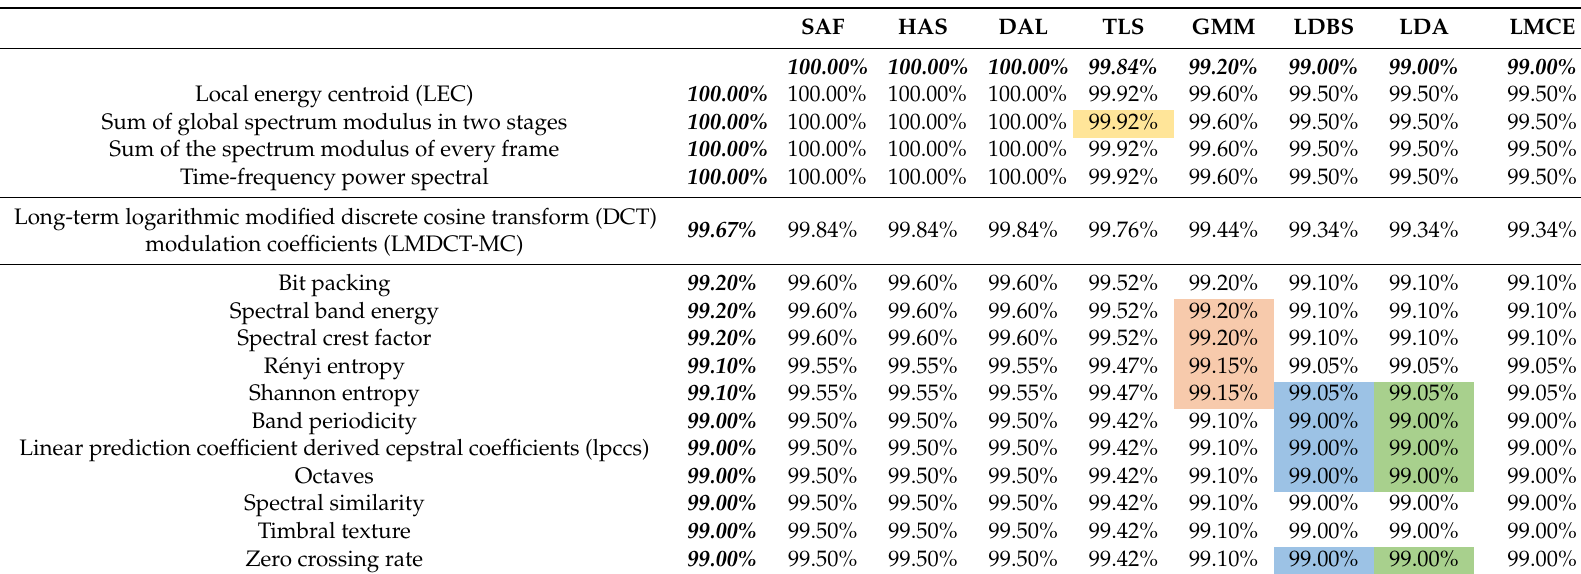
Table 5. Potential accuracies for the top most accurate methods vs. top most mean accurate features (mean accuracies equal or higher than 99%, according to its authors).